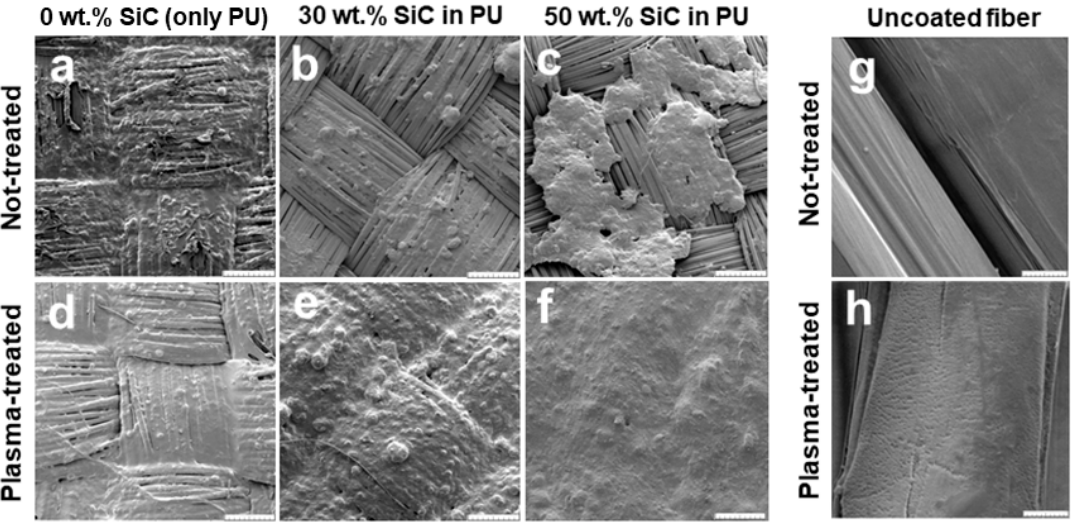
Figure 3. ( a – f ) Top view before-puncture test scanning electron microscope (SEM) images of plasma-treated and not-treated ultra-high molecular weight polyethylene (UHMWPE) fabrics coated with different mixtures of SiC in PU. The scale bar is 500 µm. ( g , h ) Plasma-treated and not-treated UHMWPE fibers. The scale bar is 10